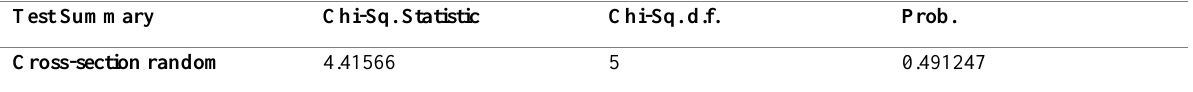
Table 7: Results of the Random Effects-Hausman